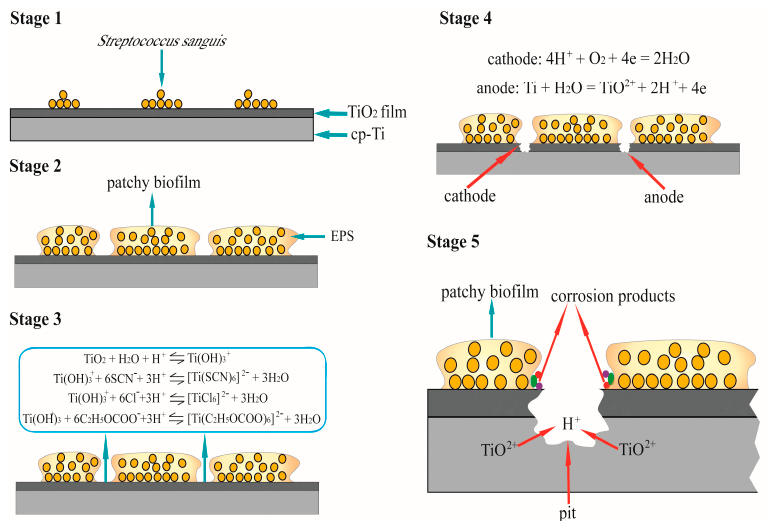
Figure 6. The formation of biofilm and its effect on titanium corrosion: ( Stage 1 ) initial attachment of S. sanguis cells to the surface of titanium; ( Stage 2 ) formation of patchy biofilm; ( Stage 3 ) dissolution of TiO 2 film amongst the patchy biofilms; ( Stage 4 ) cathodic and anodic reactions; ( Stage 5 ) formation of pit.